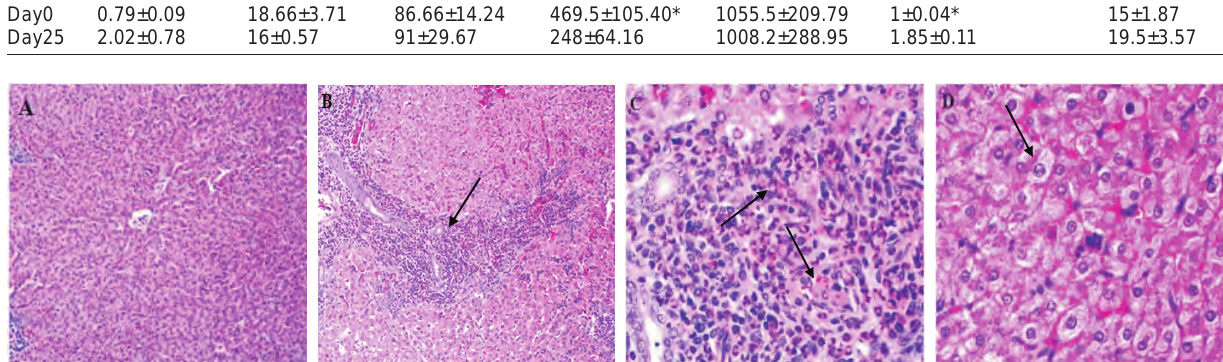
Figure-1. Liver tissue from lambs control group, lambs exposed to nano zinc at dose of 20mg/kg body weight on 25 days oral administration. (A) Liver in the control group, showing normal structure (10x). (B) Liver in the nano zinc group arrow shows eosinophilic necrosis